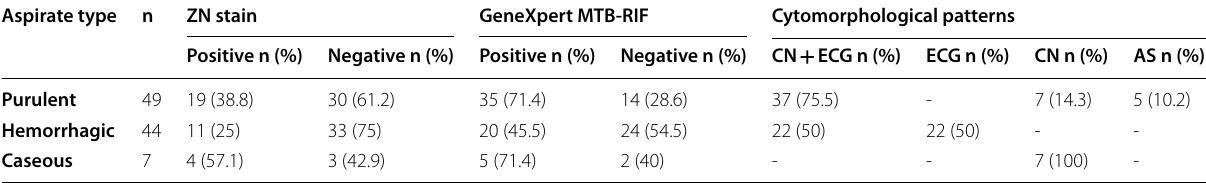
Table 4 Detection of TBLN in association with aspirate types using ZN, GeneXpert MTB-RIF and cytolomorphological patterns Aspirate type n ZN stain GeneXpert MTB‑RIF Cytomorphological